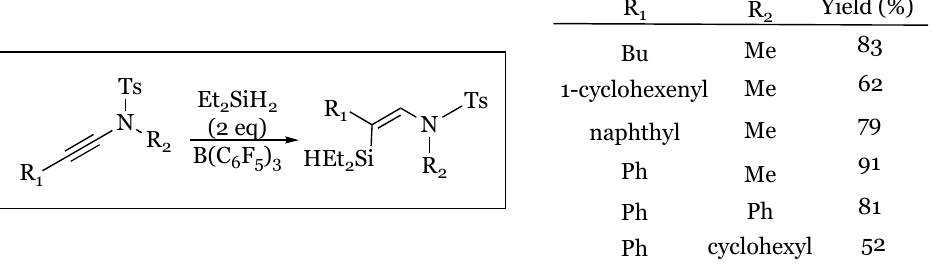
Figure 23. Hydrosilylation of internal ynamides to give silyl enamides.